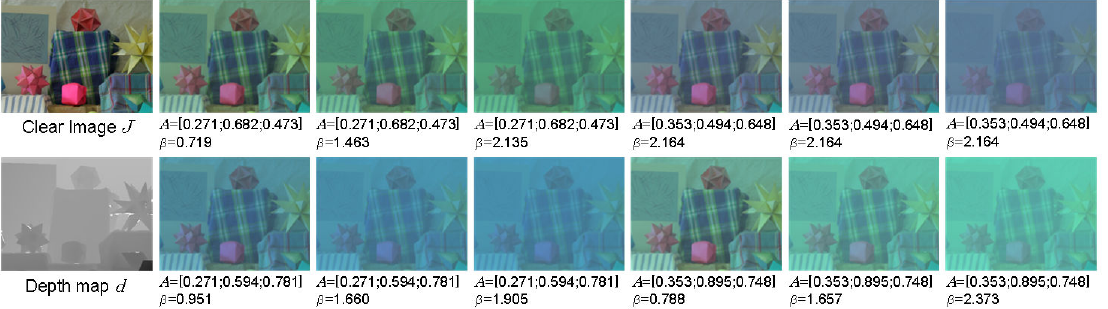
Figure 12. Synthetic samples. The images in the first column are from Middlebury Stereo dataset. The others are synthetic underwater images with different global ambient light and blue channel attenuation